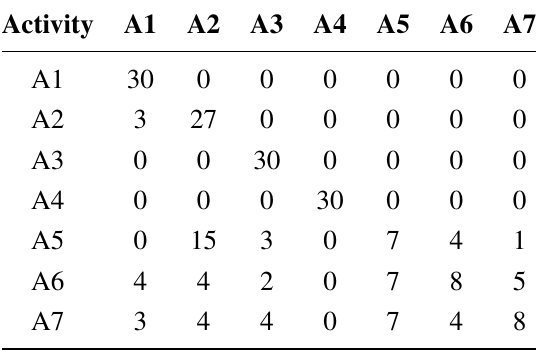
Table 3. Confusion matrix for Soccer Smartphone data for Experiment 1.